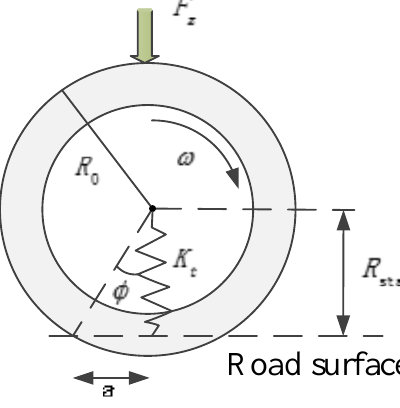
T i r e s p ee d Figure 4. Tire longitudinal force diagram. 2.4. Tire Effective Model Construction When the wheel is stationary, the vertical load applied by the body is applied, and its static radius R stat is: 0